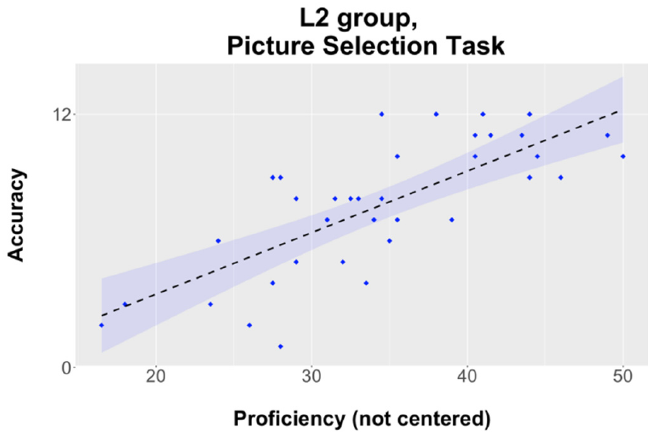
Figure 2. Scatterplot of proficiency/v/overall accuracy, picture selection task (L2 group).